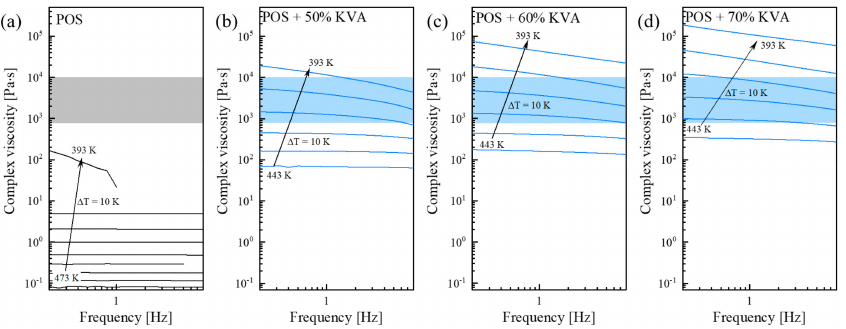
Figure 5. Complex viscosity as a function of frequency, measured at various temperature conditions, for ( a ) neat POS, ( b ) POS + 50% KVA, ( c ) POS + 60% KVA, and ( d ) POS + 70% KVA. The shaded area indicates the generally accepted “rule–of–thumb viscosity range” for small–scale